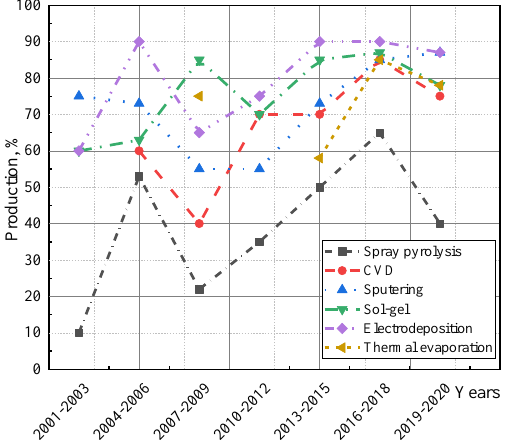
Figure 24. Contrast response curves for WO 3 films obtained by different processes during the reporting period.